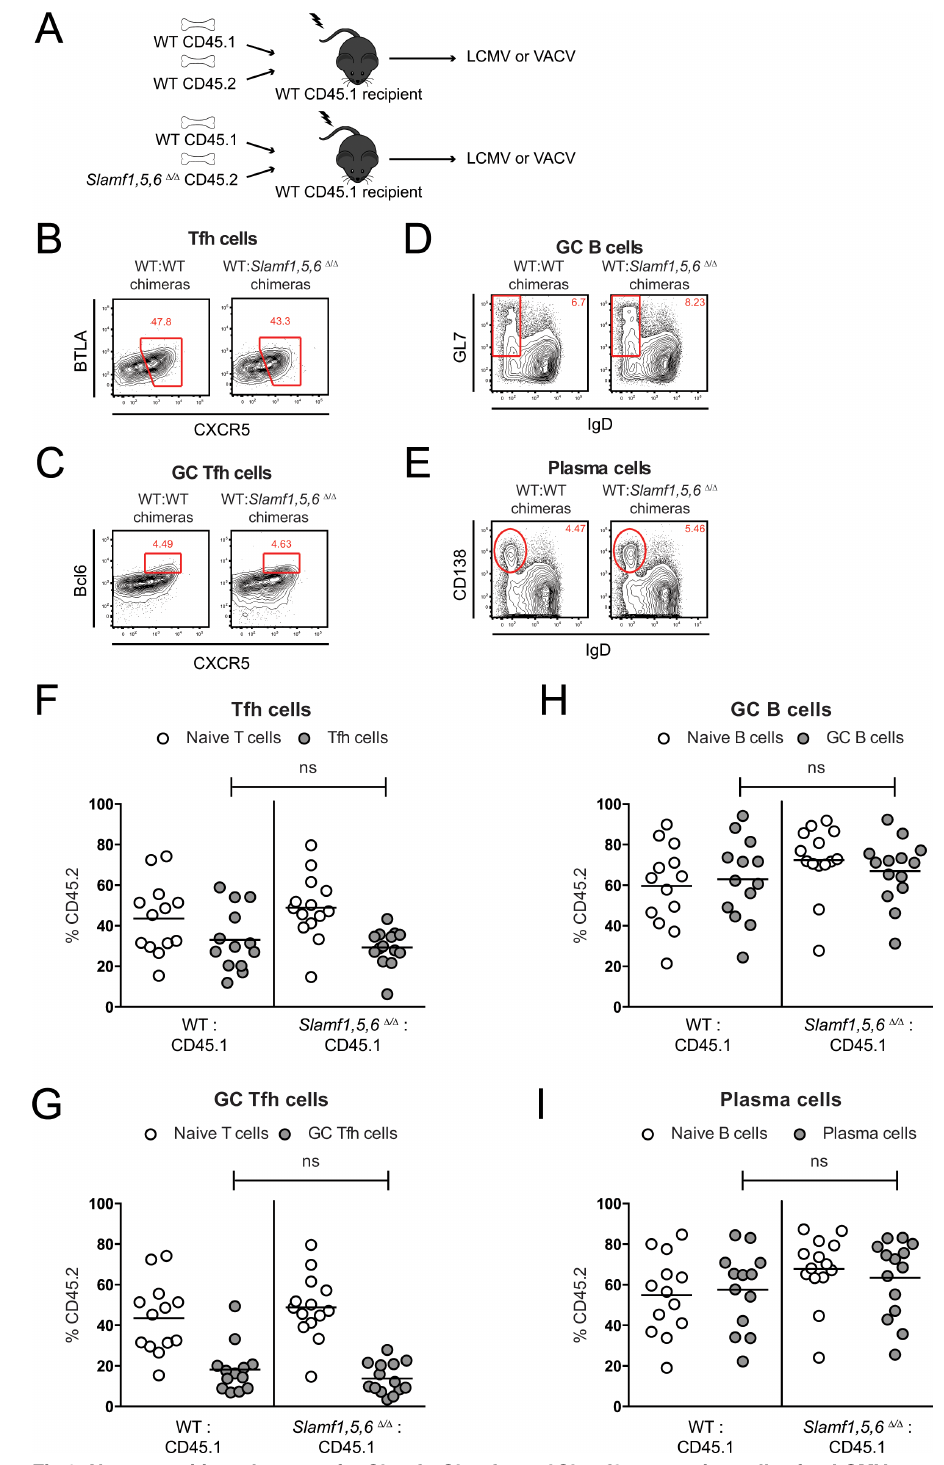
Fig 6. No competitive advantage for Slamf1 , Slamf5 , and Slamf6 -expressing cells after LCMV infection. (A) Mixed WT CD45.1 and WT CD45.2 control bone marrow (BM) chimeras or mixed WT CD45.1 and SLAMf1,5,6 Δ / Δ CD45.2 BM chimeras were made and infected with LCMV or VACV. (B-I) Bone marrow chimeras infected with LCMV. Flow cytometry plots of CD19 - CD4 + CD44 + CXCR5 + BTLA + Tfh cells (B), CD19 - CD4 + CD44 + CXCR5 + Bcl6 + GC Tfh cells (C), CD4 - CD19 + IgD - GL7 + GC B cells (D) and CD4 - CD19